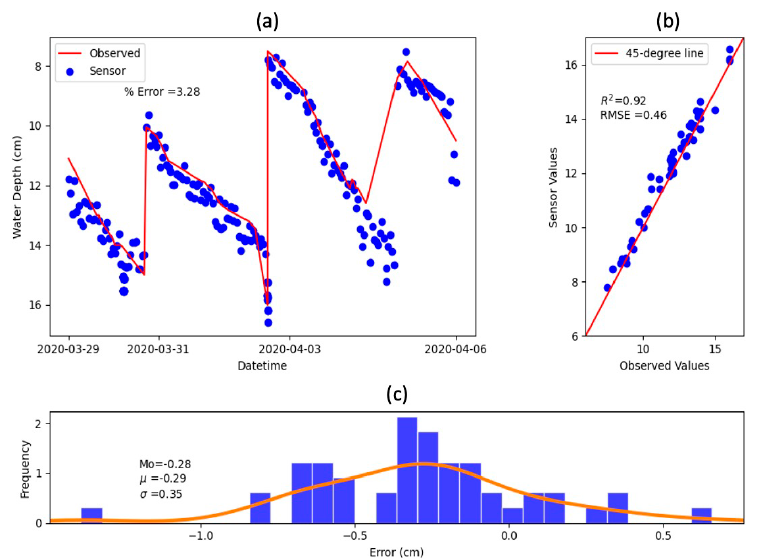
Figure 7. Laboratory-based performance test of Sensor 1 showing ( a ) observed and sensor’s water level measurements through time, ( b ) comparison of observed and sensor values, and ( c ) error (observed-sensor) distribution with Gaussian KDF fit.